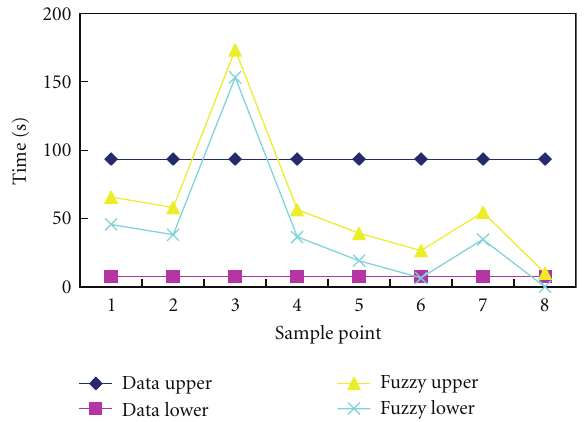
Figure 5: Comparison of the di ff erences between upper and lower